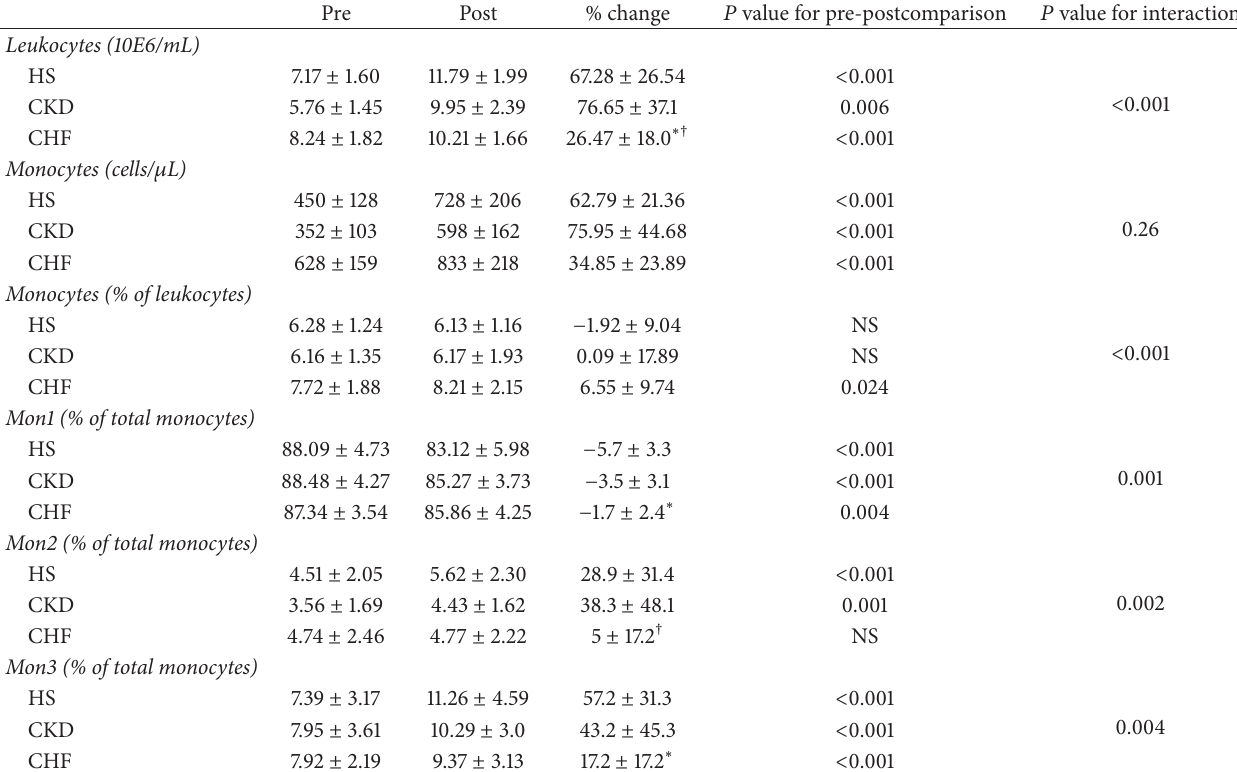
Table 3: Effect of an acute exercise bout on leukocyte and monocyte distribution.